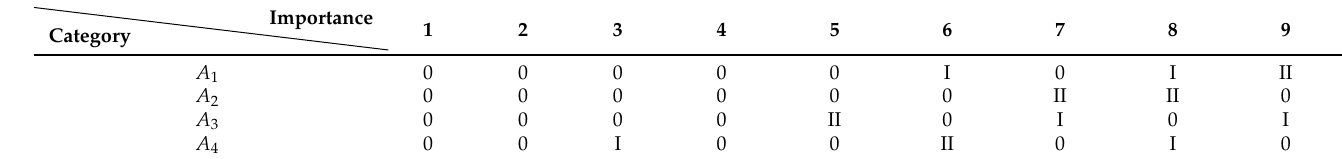
Table 4. The overall results for categories from all